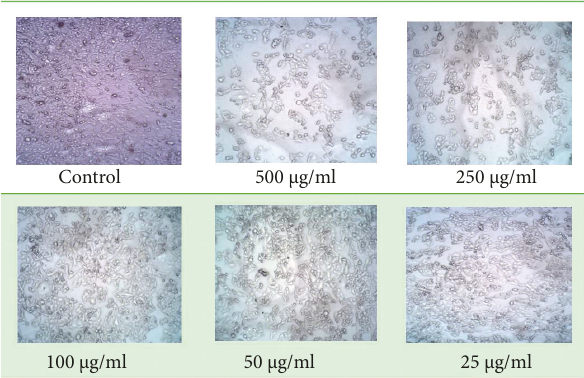
Figure 21: Cell viability images of complex 1